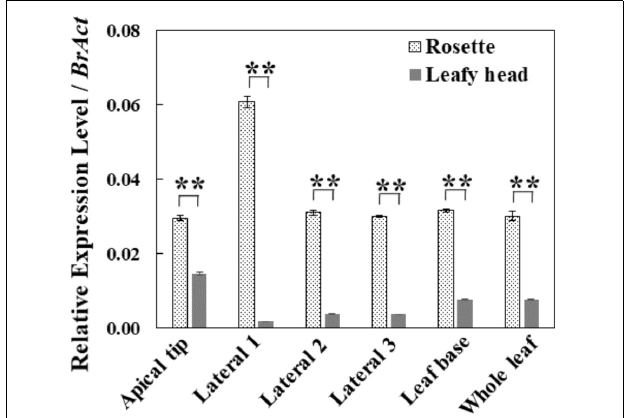
( Supplementary Figure S1 ). The existence of the same